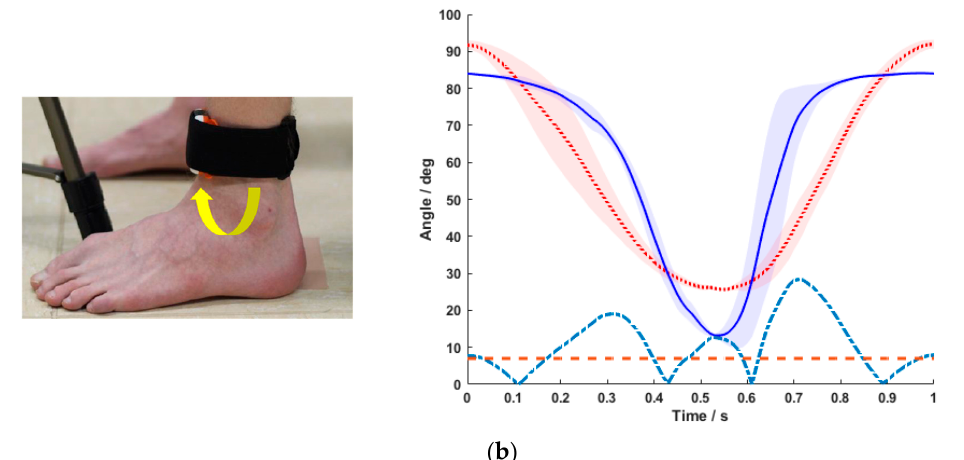
Figure 4. Mean ± SD of the five normalized movement cycles for the BPMpathway (full blue line) and the BIOPAC goniometer (dotted red line) with the difference between the means (dashed turquoise line) and the 7° tolerance threshold line (dashed red line) for sensor positioning 45° ventrally ( a ), and 90° ventrally from the prescribed position ( b ).